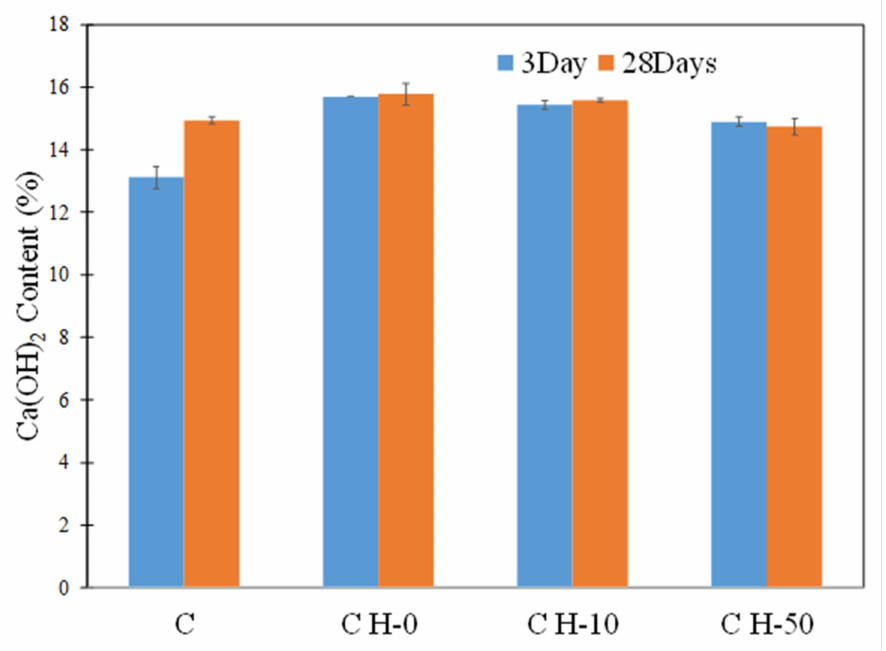
Figure 7. CH content of the control cement paste and pastes containing hydrogels at different